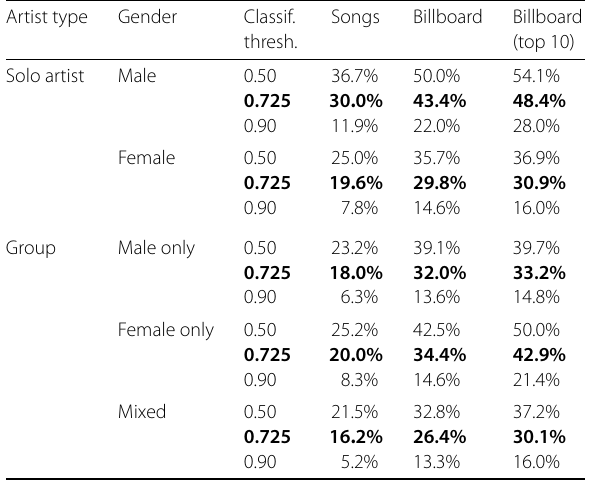
Table 5 Percentage of sexist songs identified for each artist type and gender. Results for three different classification thresholds (0.50, 0.725 and 0.90) and N B = 1 are reported, with results for the optimal threshold in bold. Percentages correspond to the fraction of sexist lyrics within the artist type and gender Artist type Gender Classif. Songs Billboard Billboard thresh. (top 10) Solo artist Male 0.50 36.7% 50.0% 54.1% 0.725 30 . 0% 43.4% 48.4% 0.90 0.50